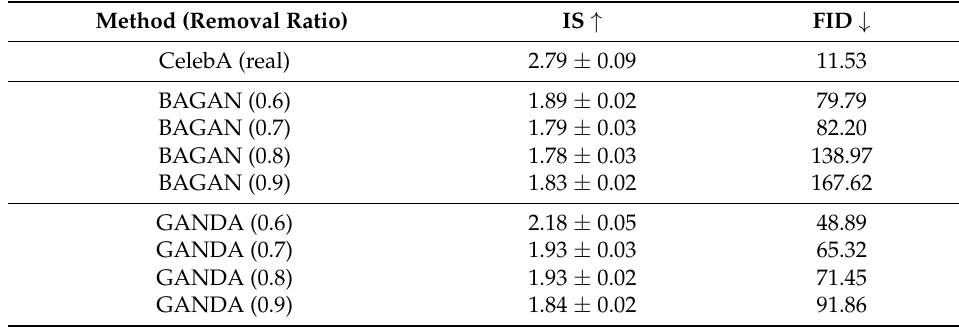
Figure 6. Data augmentation using the CIFAR-10 dataset. For each block with three rows, the first, second, and third rows contain real images, generated images using autoencoding, and generated images using the proposed method, respectively. Table 2. Comparison of the proposed GANDA with BAGAN on the CelebA dataset in terms of IS and FID (IS: higher is better, FID: lower is